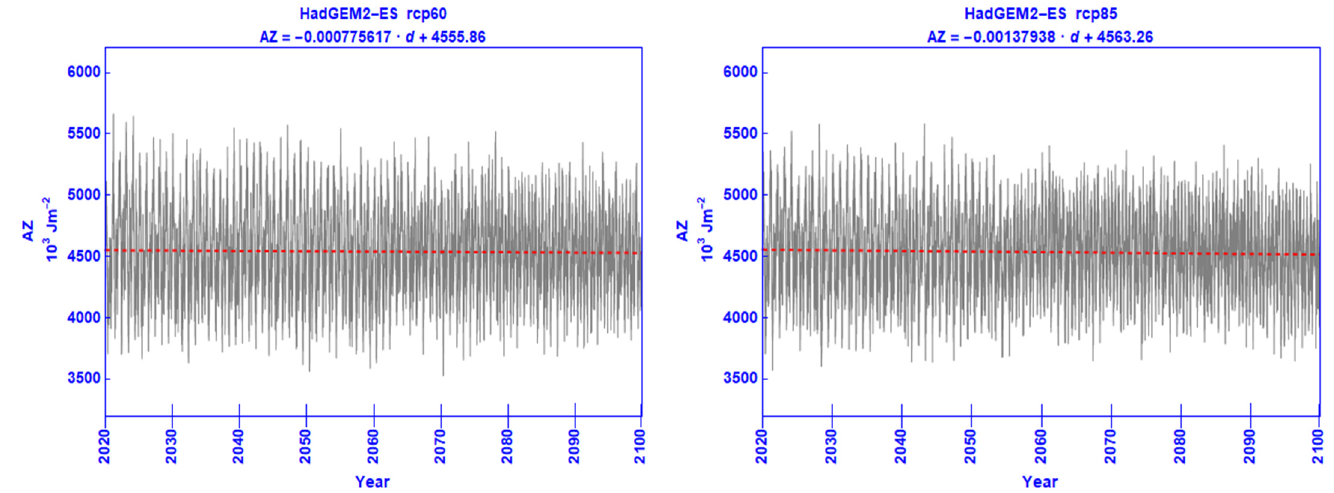
Figure 3. Time series for AZ corresponding to each Representative Concentration Pathway: rcp26 ( top left ), rcp45 ( top right ), rcp60 ( bottom left , and rcp85 ( bottom right ). The fitted linear regression for this energy content is given at the top of each diagram as a function of day ( d ).